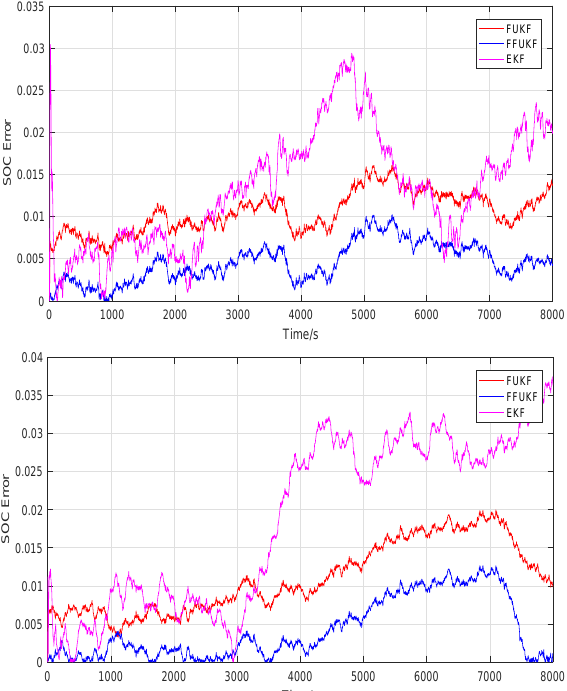
Figure 15. The SOC estimation error curves under BJDST and FUDS at 45 ◦